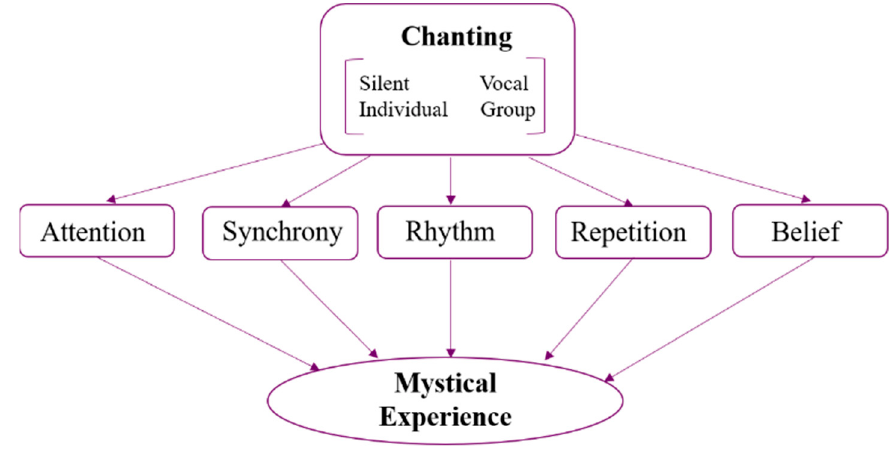
Figure 1. Convergence of features that may promote mystical experience during chanting. Little is known about skills or personality traits associated with mystical